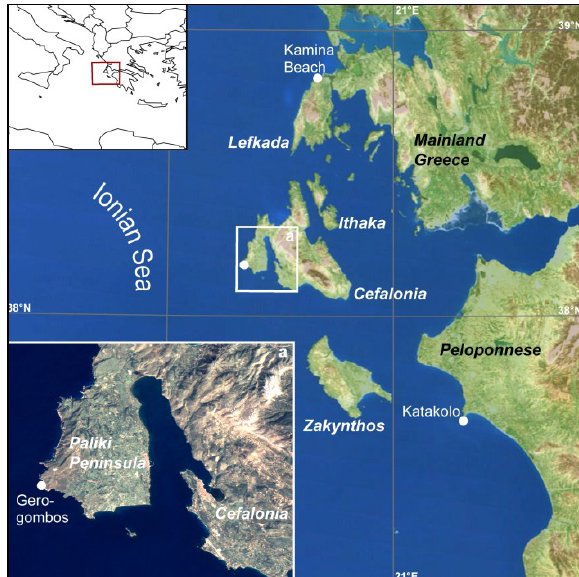
Figure 1. Map of the measurement sites on the Peloponnese Peninsula and the two Ioanian Islands of Cefalonia and Lefkada. Map based on Modis and ASTER GDEM data. Inset map based on Landsat